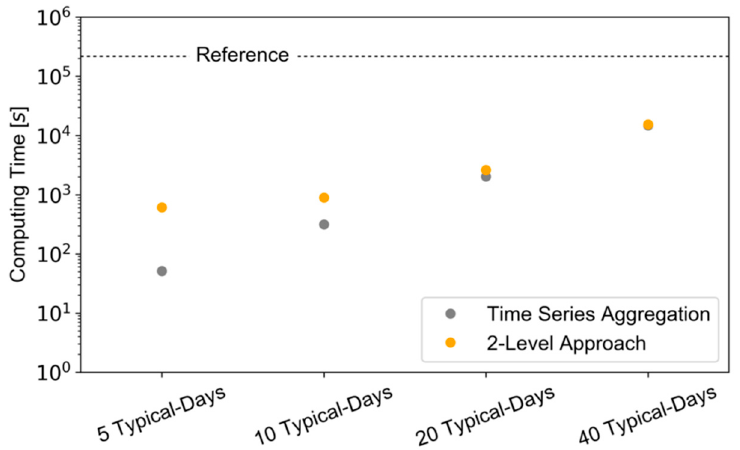
Figure 5. Comparison of the computing time.